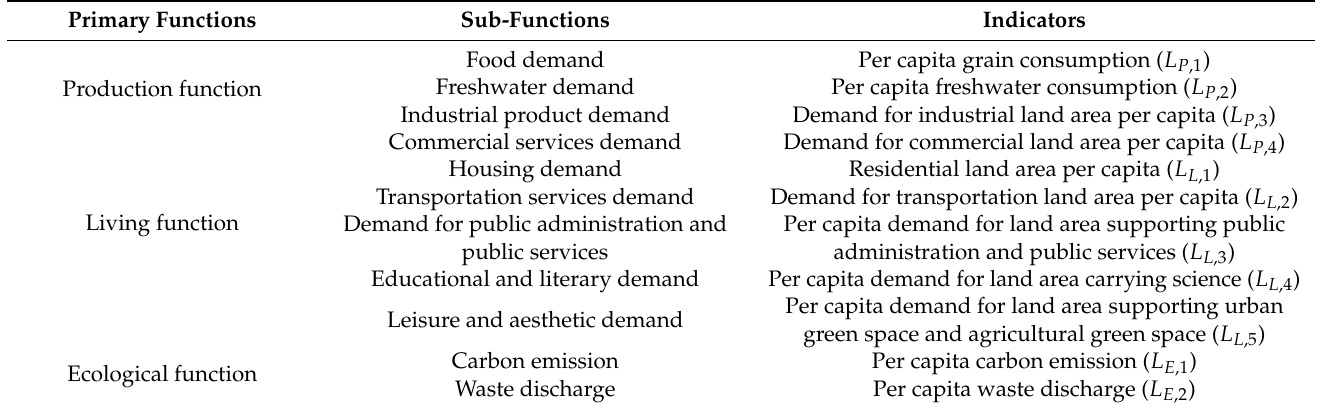
Table 5. Indicators for measuring land resources